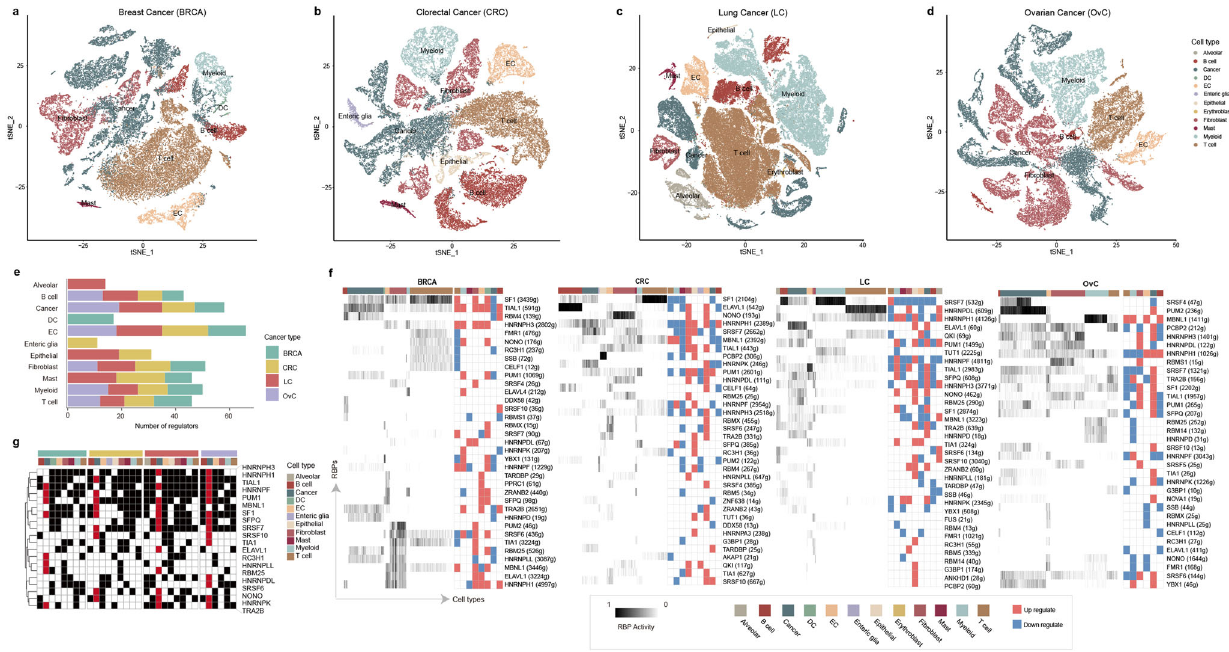
Fig. 2 RBP regulators identi fi ed in four cancer types. a – d t-SNE representation for BRCA, CRC, LC and OvC. Color-coded for cell types. e The number of RBP regulators identi fi ed in different cell types across cancers. f Heatmap of RBP regulatory activity in different cell types across cancers. The numbers with the parenthesis mean the number of potentially target genes of RBPs. The heat maps on the right panels were for differential expressions of RBPs. Red for upregulated and blue for downregulated. g Heatmap showing the commonly activated RBP regulators in pan-cancer. The black and red in the heap map indicated that the RBPs were active in corresponding cell types and red is highlighting the cancer cell